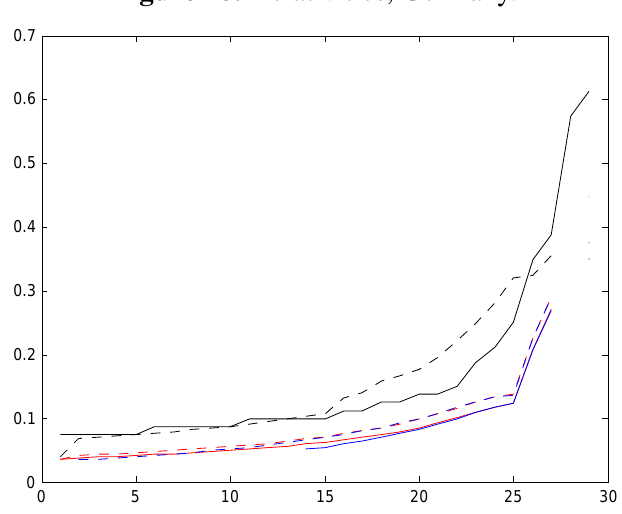
Figure 18. Relativities,